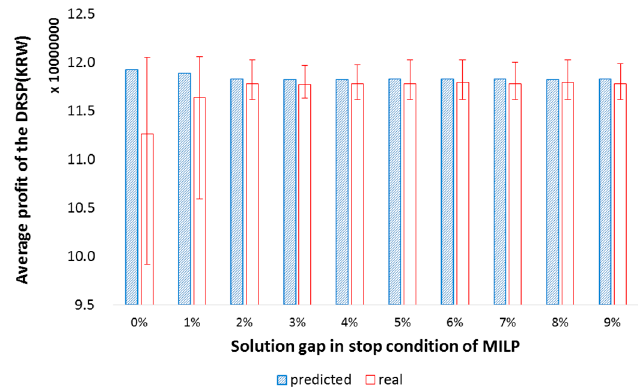
Figure 6. Average profit of the proposed method with different stop conditions. The number of simulations ( K ) is fixed to 250. The perfect optimum point does not provide the best result in real test data, because of the over-fitting problem. A 2% gap in the stop condition can provide a better result, providing generalization ability in data driven methods. KRW refers to the currency of Korea (Korean Won).